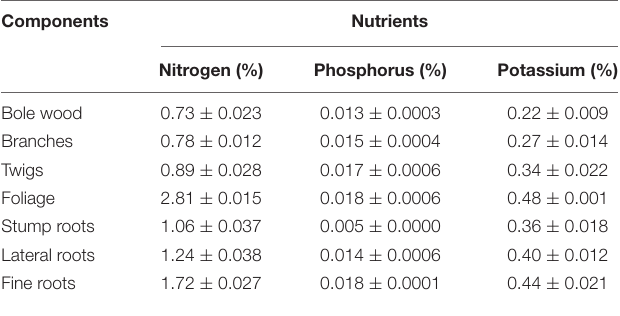
TABLE 2 | Mean nutrient concentration (Mean ± SE) (N, P, and K) in different components of C. nepalensis of 3 CBH classes (0–20, 20–40, and above 40 cm) of harvested sample ( n = 3) across the